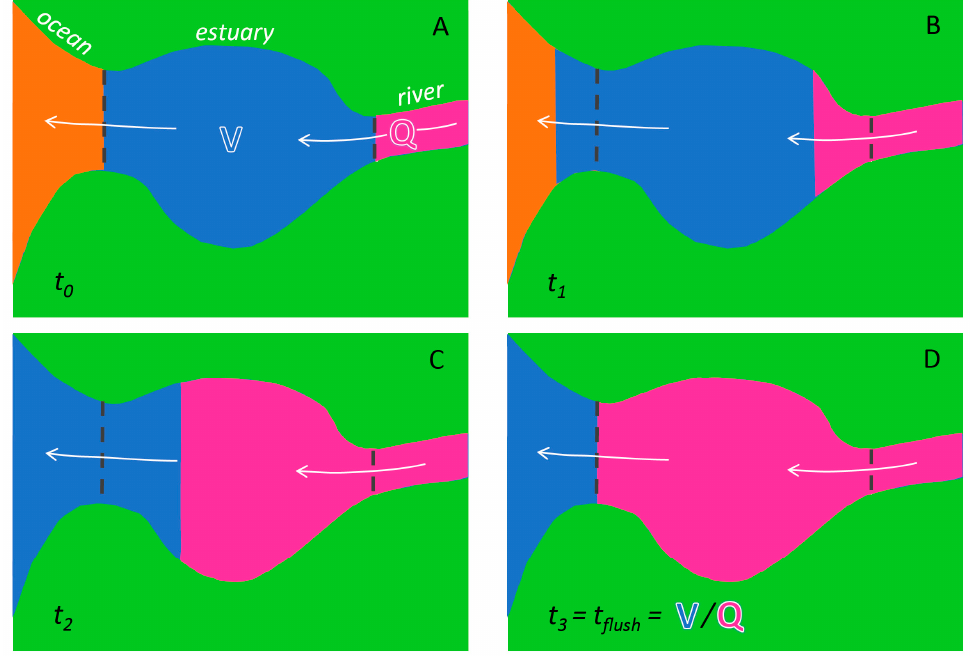
Figure 4. Simplified depiction of advective, river-driven estuarine flushing, idealized as plug flow (perfect mixing over the flow cross section, zero mixing in the streamwise direction). Panels ( A – D ) follow a progression through time of river water gradually replacing estuarine water initially present at time t 0 . V is estuarine volume, and Q is river discharge. River water is depicted as magenta; original estuarine water is blue; water outside the estuary mouth is orange. Gray dashed lines represent upstream and downstream boundaries of the